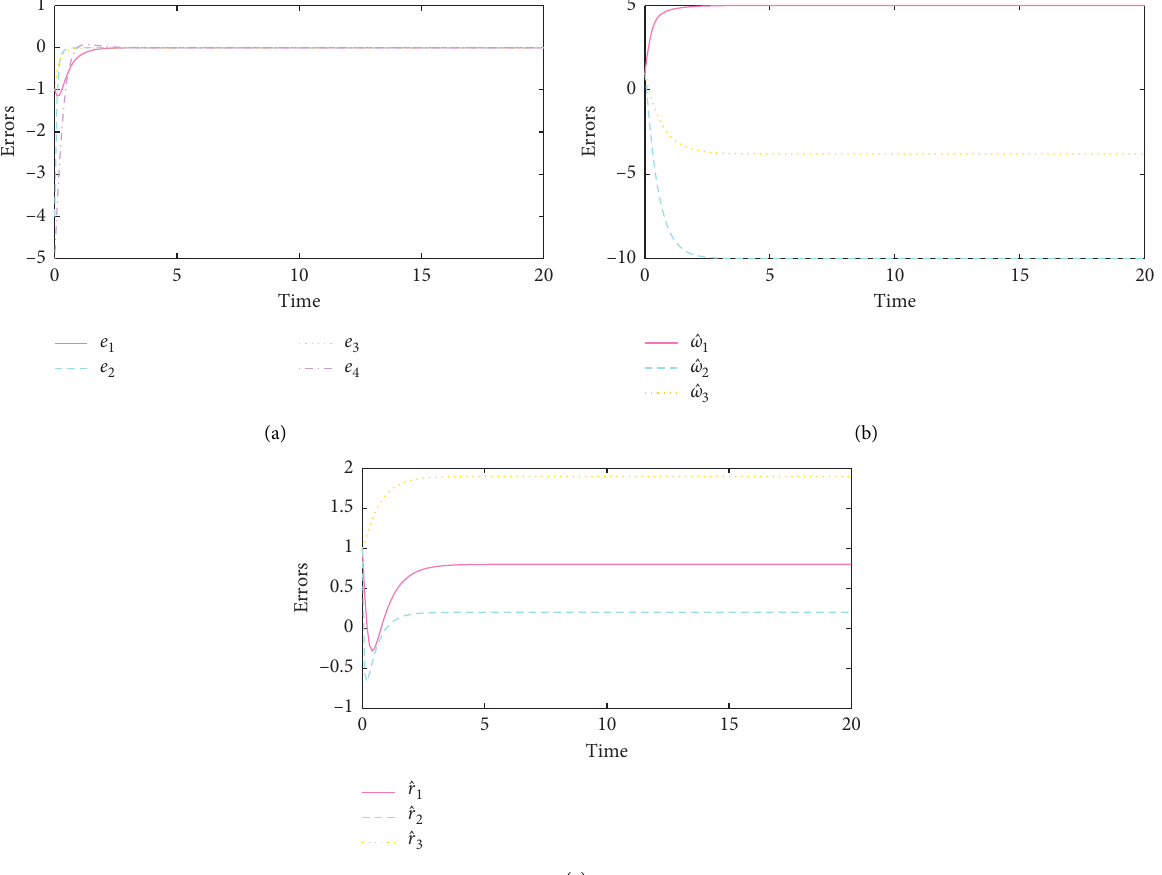
Figure 9: Typical dynamical behaviors of the hyperchaotic Chen–Lee system: (a) projection in ( y ( y